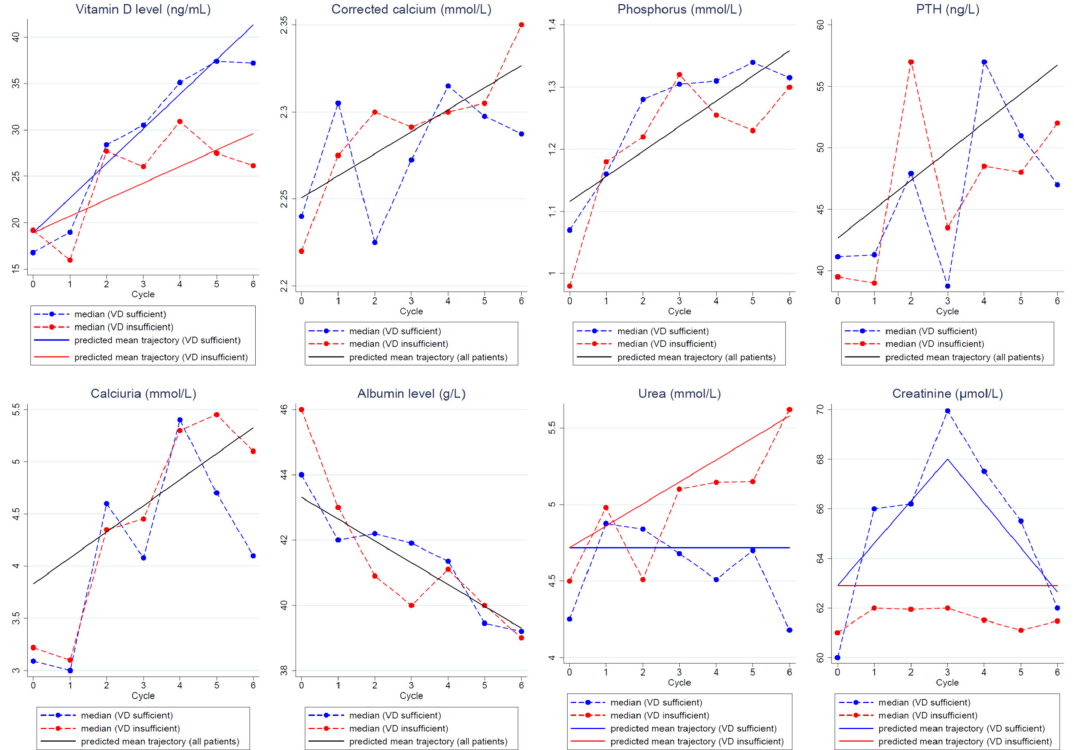
Figure 2. Predicted mean trajectories (solid lines) from the linear mixed models in patients with and without VD concentra- tion normalization on D1C6 or in the whole population if the trajectories were or were not significantly different between groups, respectively. Dashed lines, observed median values in patients with (blue) and without VD concentration normalization (red). Abbreviations: PTH: parathormone, VD: vitamin D.